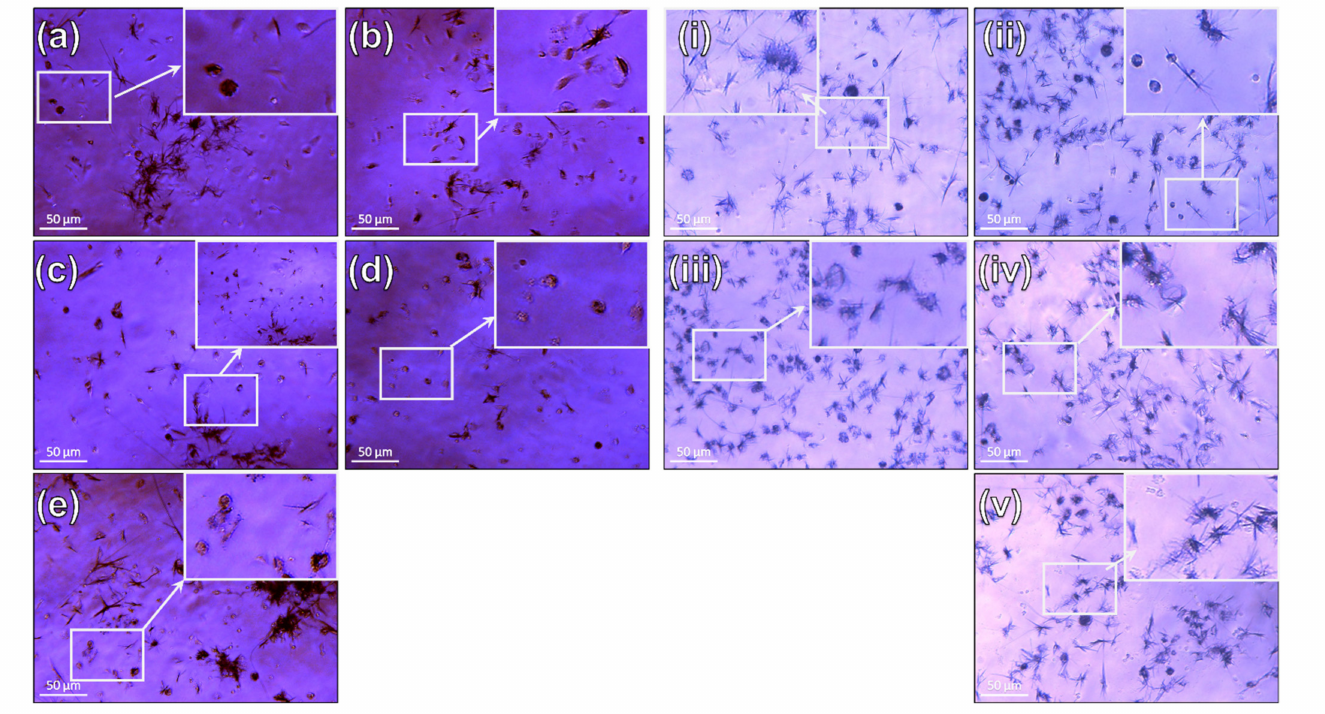
Figure 7. Macrophages post-MTT observed with OPCM at 3 days ( a – e ) and 5 days ( i – v ) of incubation (200 × ): ( a , i ) control; ( b , ii ) conditioned medium with AISI 316L steel eluates; ( c , iii) conditioned medium with a-C:5H coating eluates; ( d , iv ) conditioned medium with a-C:10H coating eluates; ( e , v ) conditioned medium with artificial